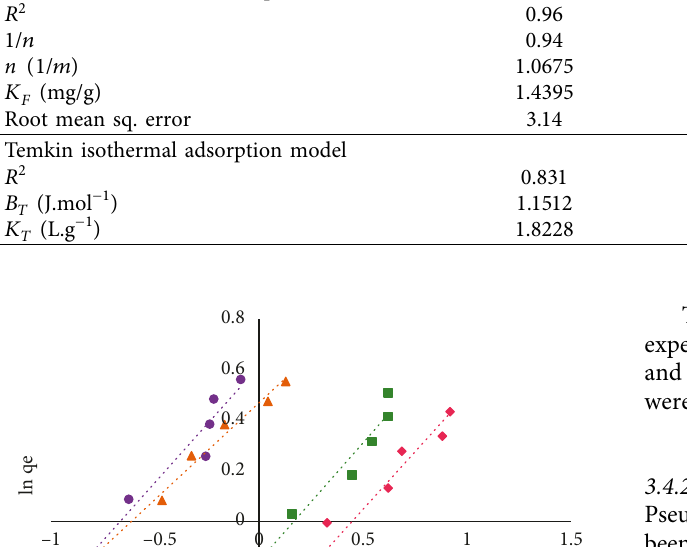
Freundlich isothermal adsorption model R 2